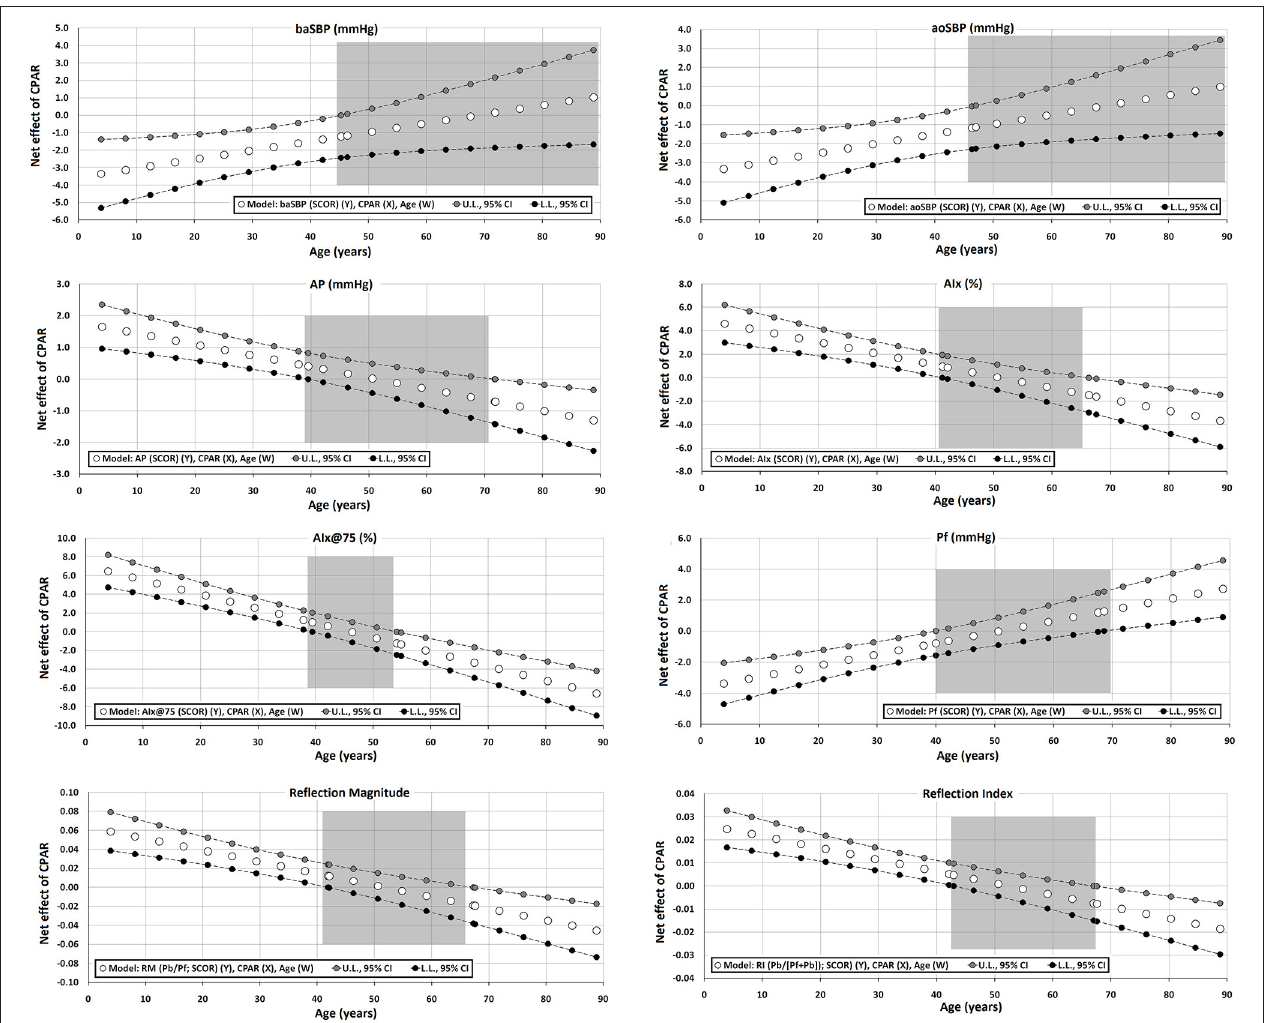
FIGURE 4 | Effect of CPAR condition on aortic blood pressure levels and waveform-derived indexes: effects at different ages throughout life. The gray area shows regions that do not reach statistical significance. Complete quantitative information related to interactions and/or Johnson-Neyman regions is detailed in Supplementary Tables 2 – 95 . In each panel, the “net or absolute conditional effect” (and its 95% confidence interval) of reaching CPARs = 1, quantified in units of the cardiovascular variable, was plotted as a function of age. If the confidence interval crosses the value “0,” the effect of CPARs on the cardiovascular variable becomes statistically non-significant ( p ≥